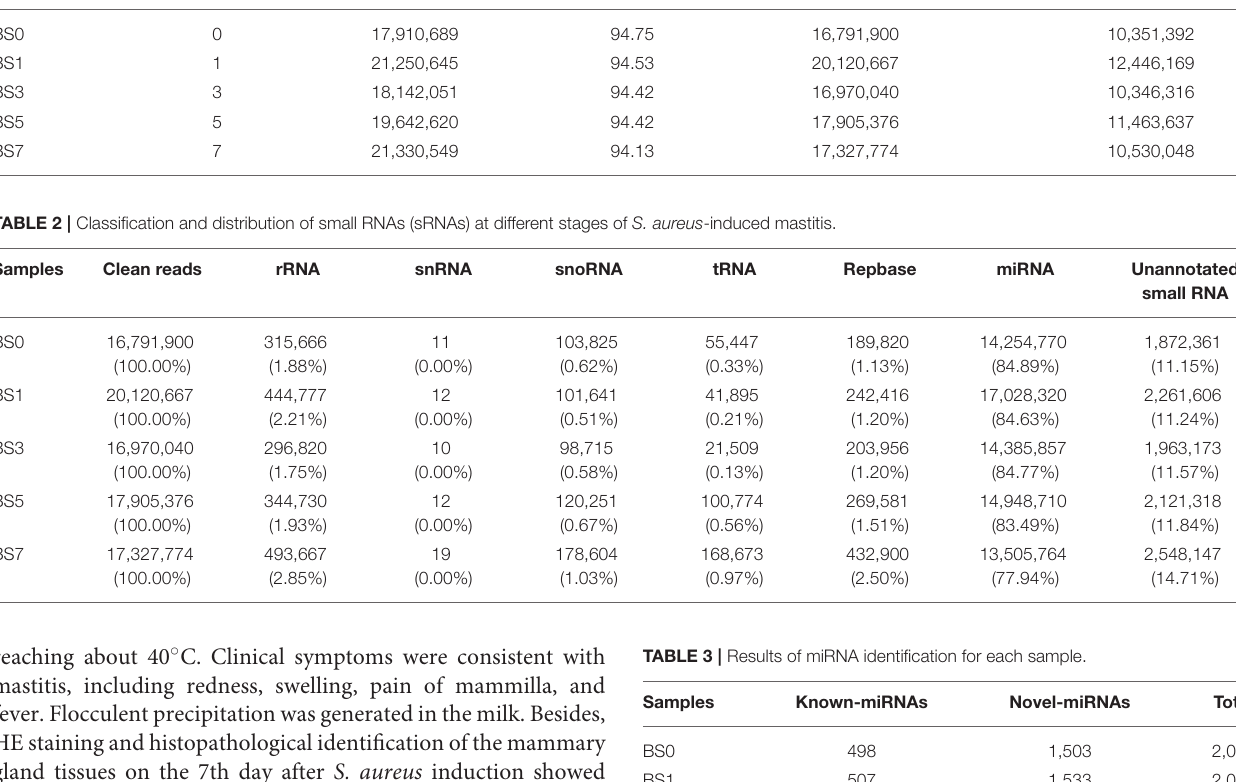
TABLE 1 | Overview of miRNA sequencing data. Samples